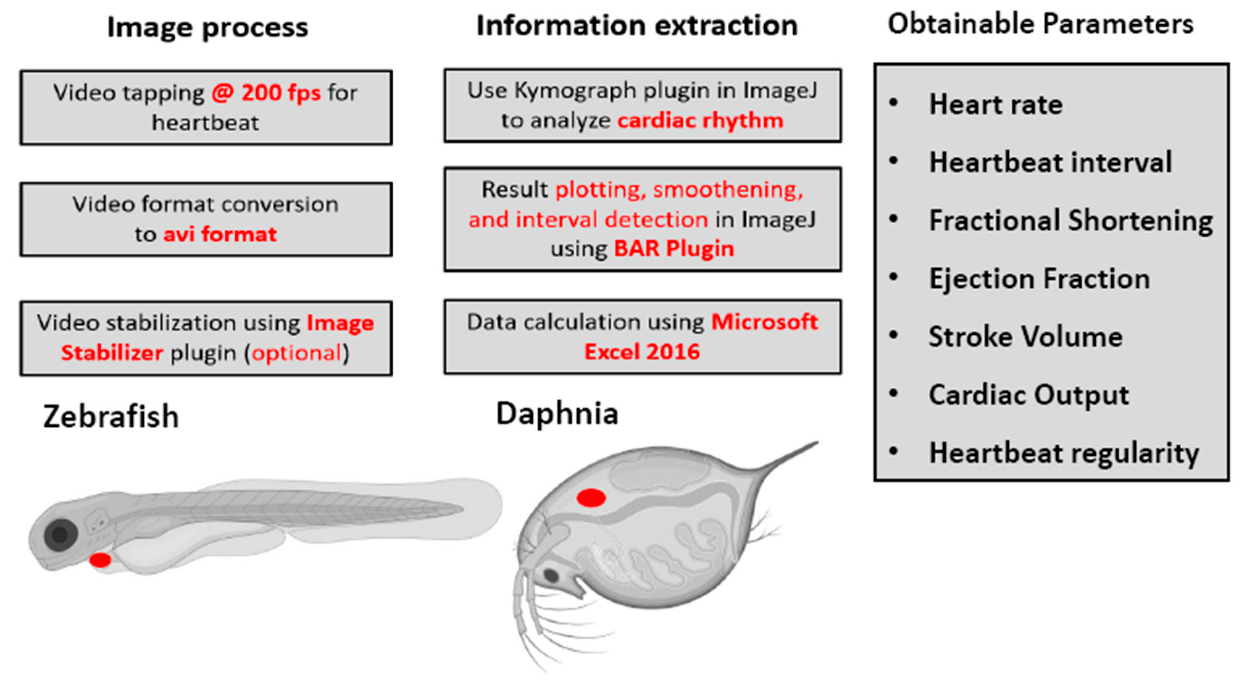
Figure 3. Overview of experimental workflow for zebrafish and Daphnia magna heartbeat measurement using the kymograph method; left panel showing image process pipeline, middle panel showing information extraction pipeline, and right panel showing the cardiac parameters that can be obtained by using this one-step kymograph method. The heart positions in zebrafish and Daphnia were highlighted by red dots in the bottom panel.